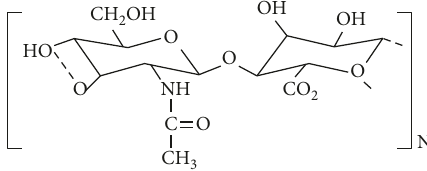
Figure 2: Structure of hyaluronic